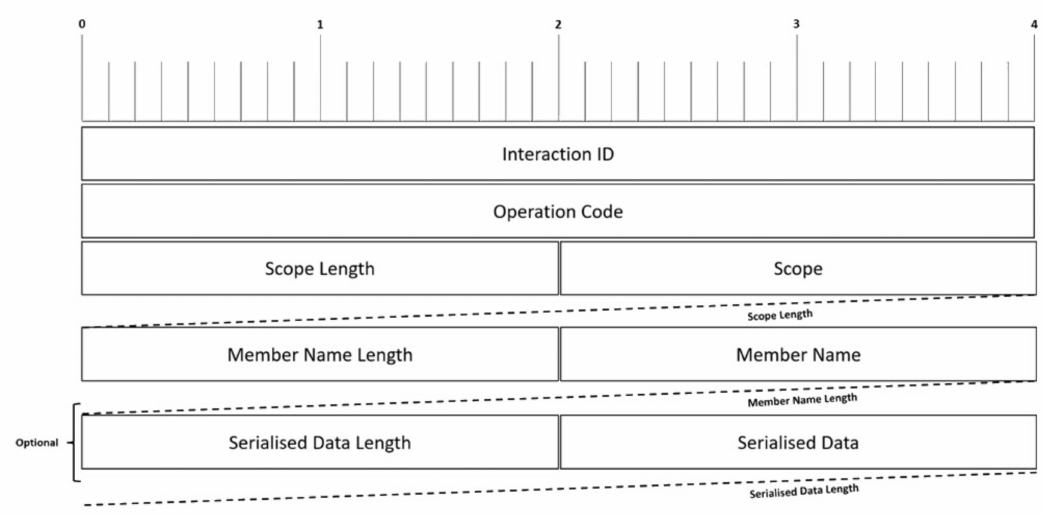
Figure 9. Bit-level packet diagram of the Intelligence Transfer Model Protocol (ITMP), as used in our candidate